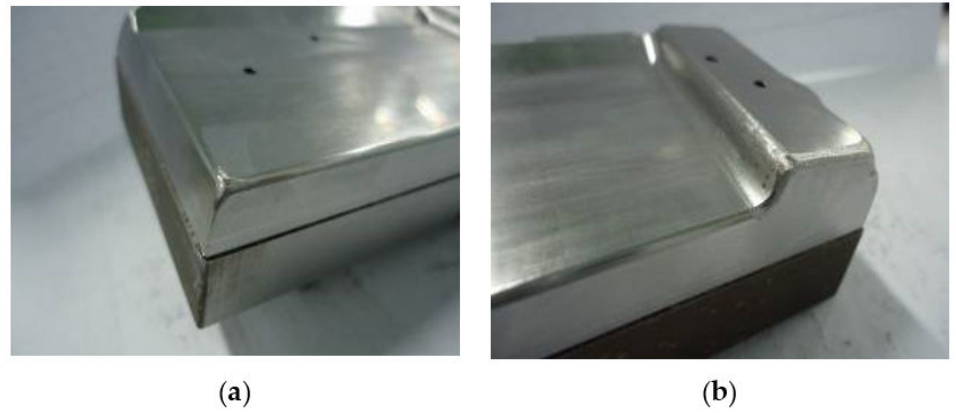
Figure 5. Two cases of the experimental punch. ( a ) Case I with R p = 0.8 mm; ( b ) Case II with R p = 2 mm.